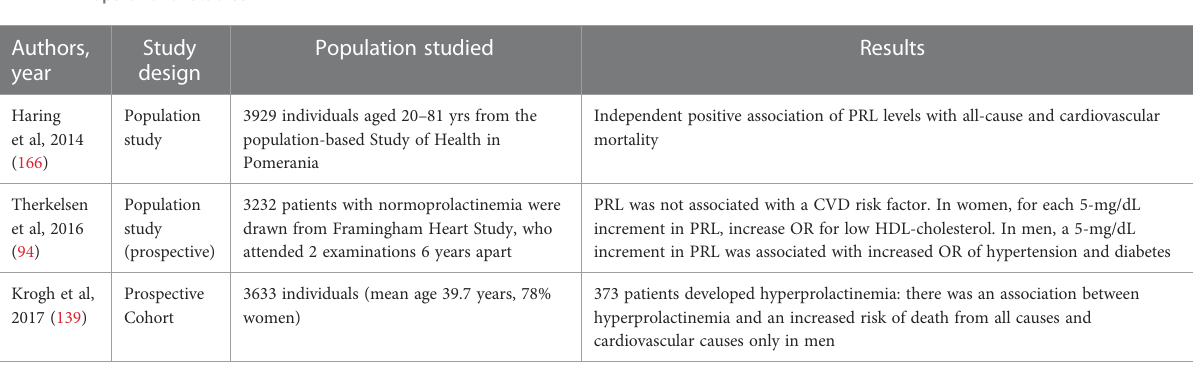
TABLE 4 Populational studies.